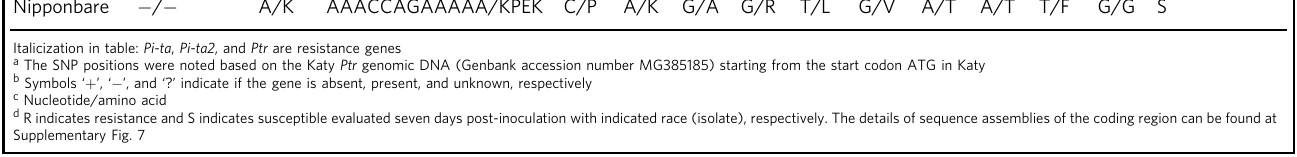
Italicization in table: Pi-ta , Pi-ta2 , and Ptr are resistance genes a The SNP positions were noted based on the Katy Ptr genomic DNA (Genbank accession number MG385185) starting from the start codon ATG in Katy b Symbols ‘ + ’ , ‘ − ’ , and ‘ ? ’ indicate if the gene is absent, present, and unknown,